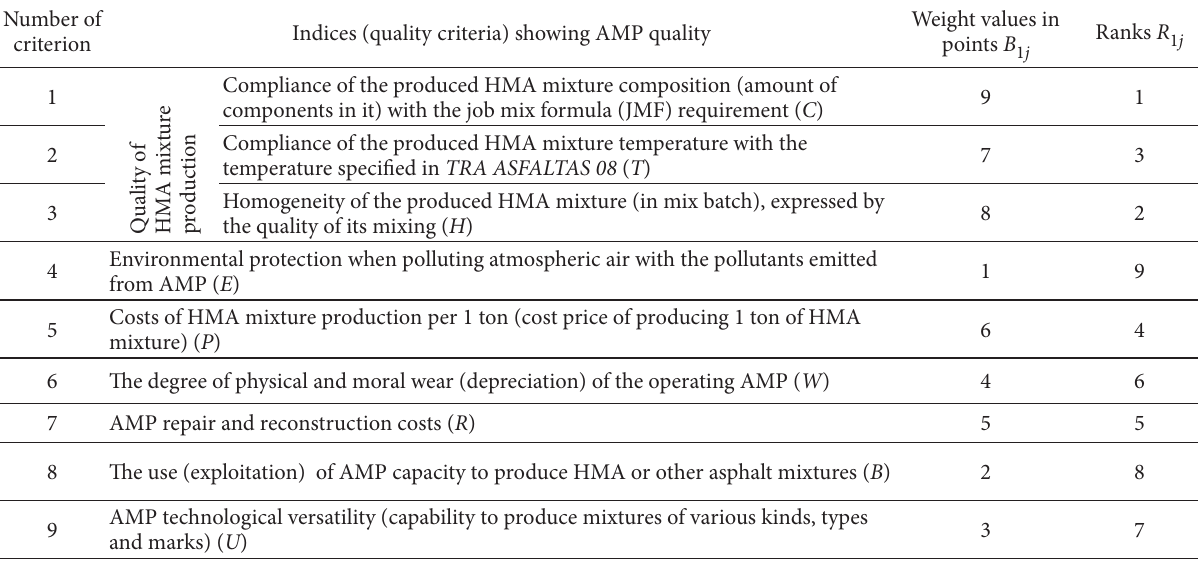
Table 3. Questionnaire of determining the weight of the operating AMP quality complex evaluation quality criteria (points B 1 j given by the 1 st expert E 1 and calculated ranks R 1 j )